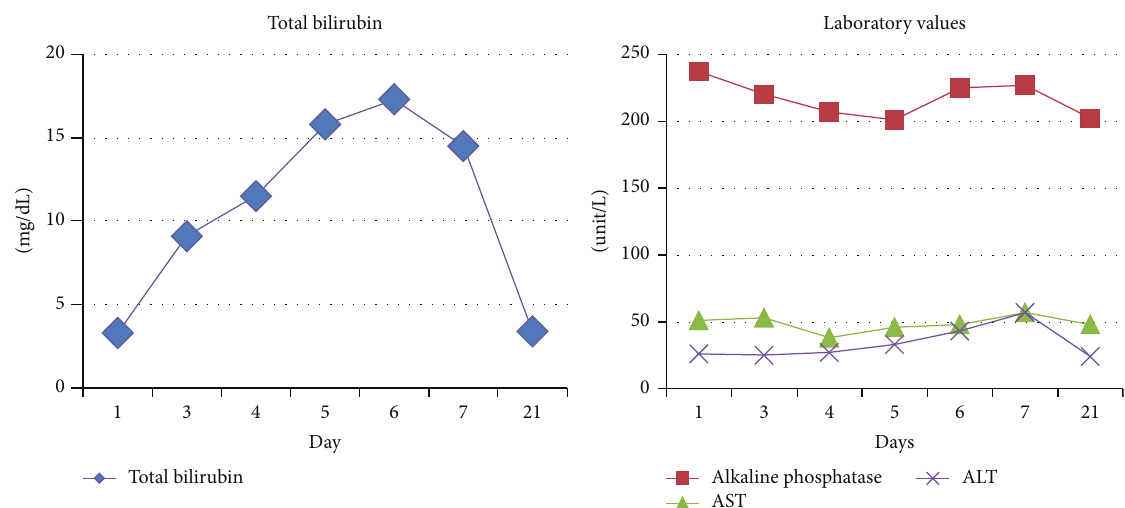
Figure 1: Trend of total bilirubin, alkaline phosphatase, AST, and ALT values from admission till outpatient follow-up.